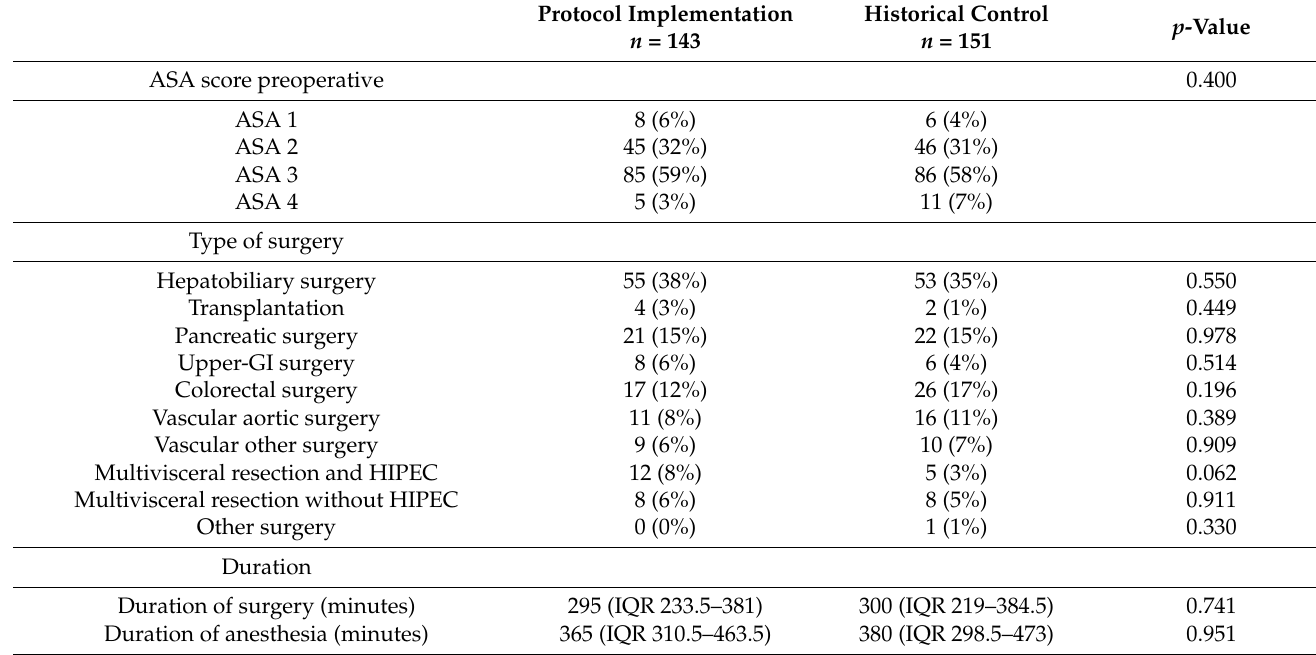
Table 2. Surgical